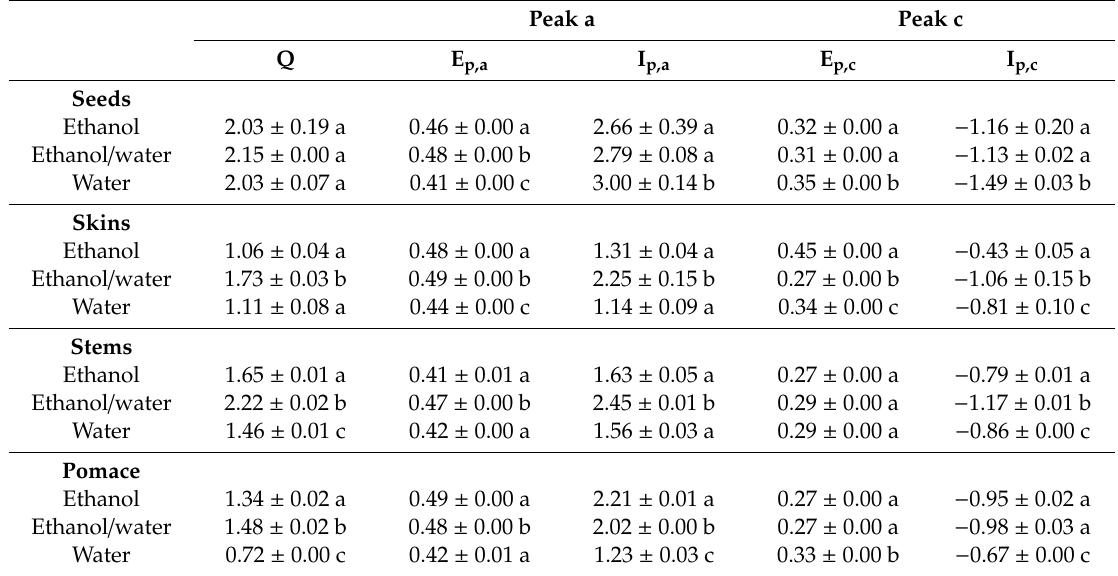
Table 3. Electrochemical parameters extracted from the cyclic voltammetry curves of the seeds, skins, stems and pomace extracts obtained with di ff erent solvents (ethanol, ethanol / water and water). Peak